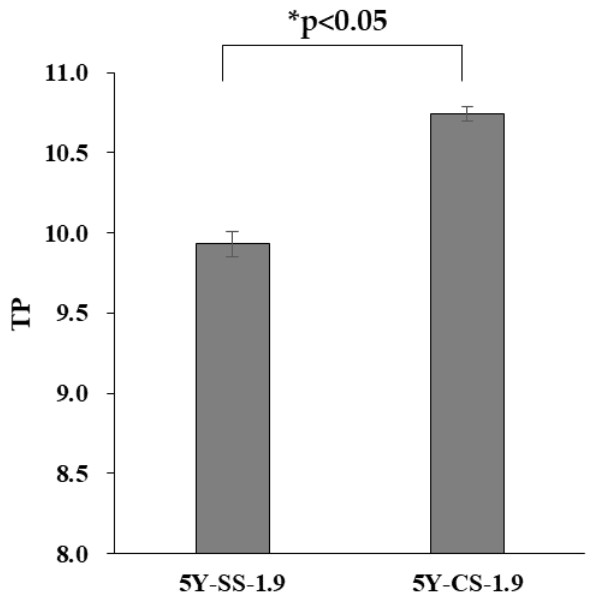
Figure 10. TP of 5Y-SS-1.9 and 5Y-CS-1.9. The asterisk refers to statistical significance